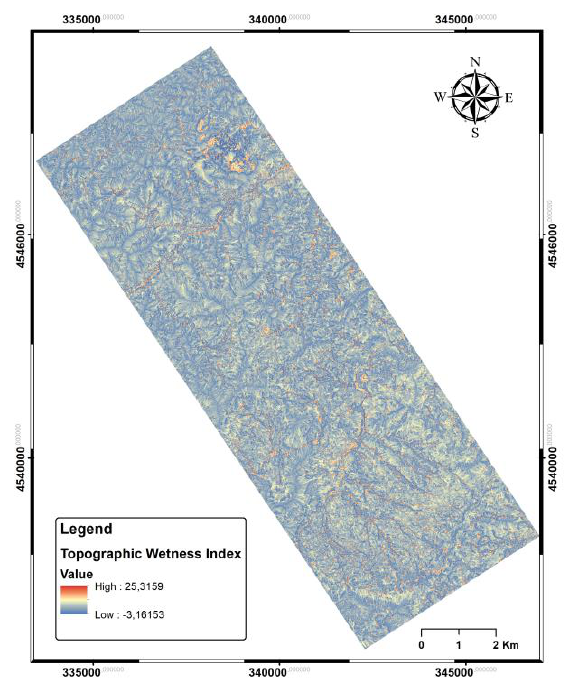
Figure 9. Profile slope curvature map of the study area.